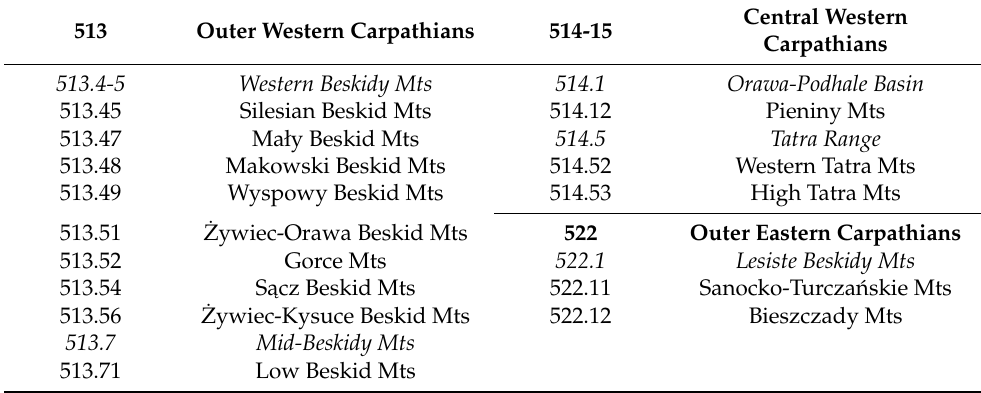
Figure 1. Study area—14 mountain ranges of the Polish Carpathians. Source: authors. Table 1. Physico-geographical region classification of the study area. Subprovinces (bolded names), macroregions (italicised names) , and mesoregions.